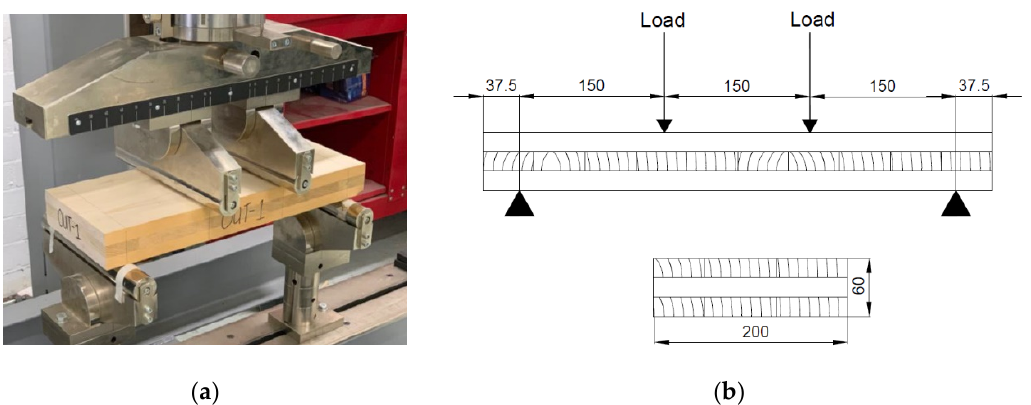
Figure 4. ( a ) The experimental test setup and ( b ) illustration of geometric dimensions of the test specimen (all measurements in mm).